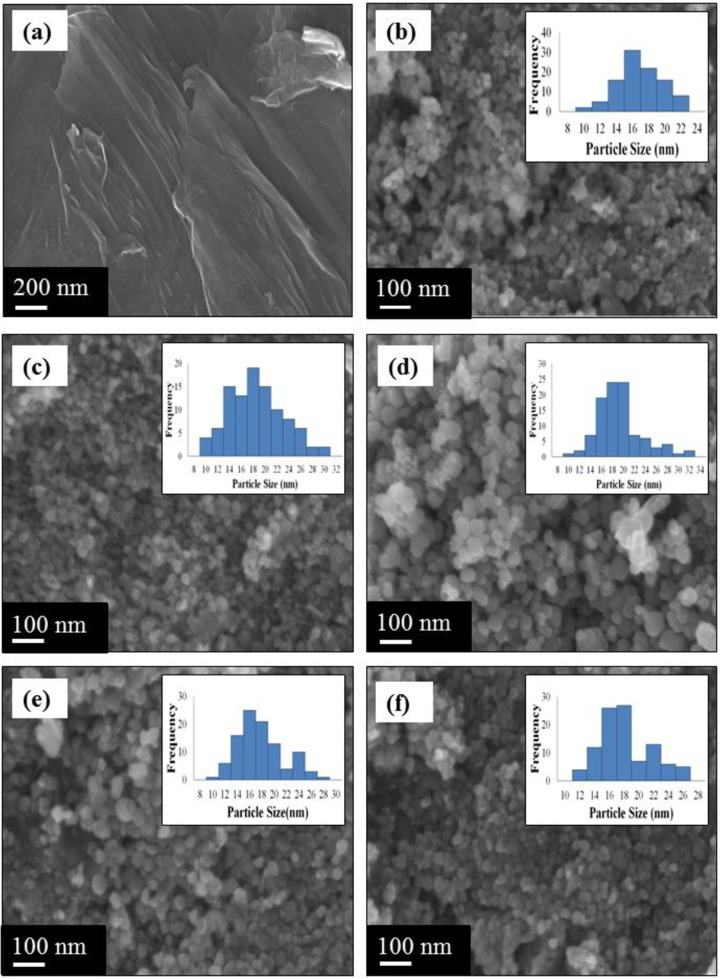
FESEM image of (a) GO. FESEM images and particle size histogram (inset) of (b) M-rGO3, (c) M-rGO6, (d) M-rGO12, (e) M-rGO18 and (f) M-rGO24.